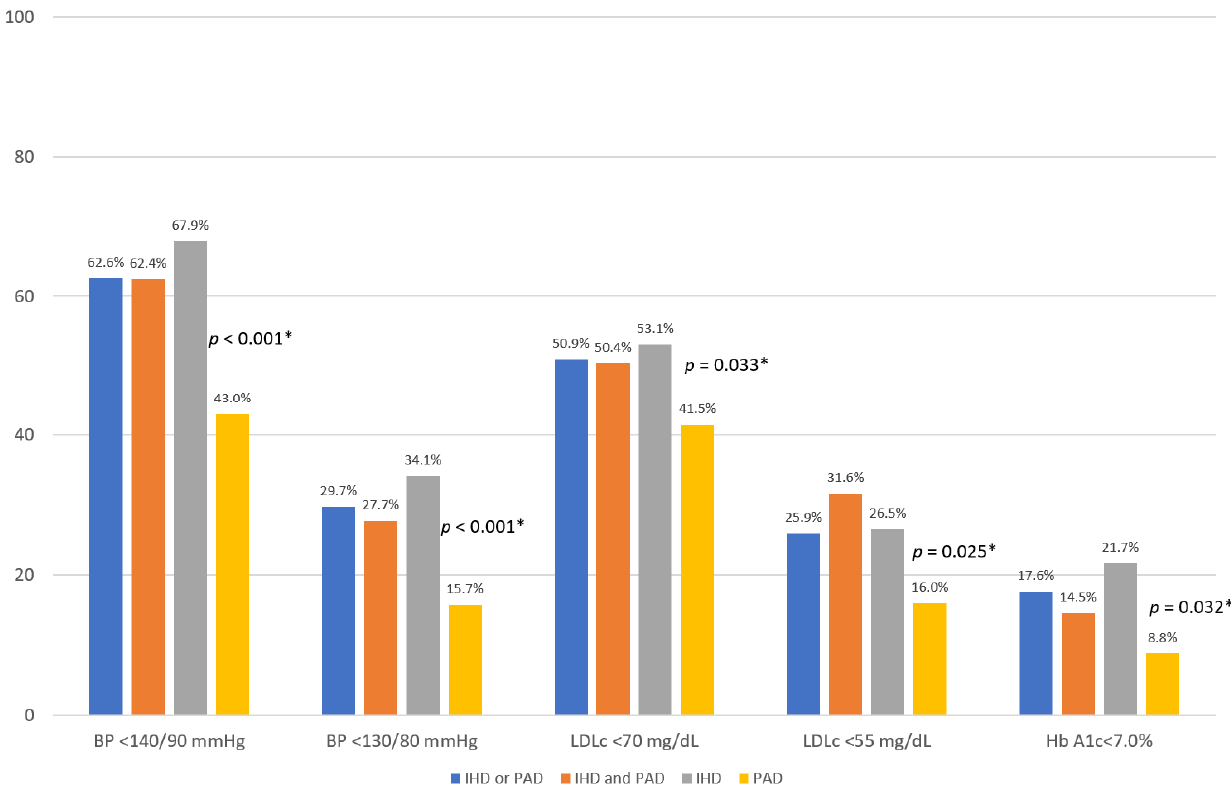
Figure 1. Proportion of patients achieving cardiovascular risk factor targets. BP: blood pressure; LDLc: LDL cholesterol; HbA1c: glycated hemoglobin; IHD: ischemic heart disease; PAD: peripheral artery disease. * p -value IHD vs. PAD. Table 4. Proportion of patients achieving cardiovascular risk factor targets .